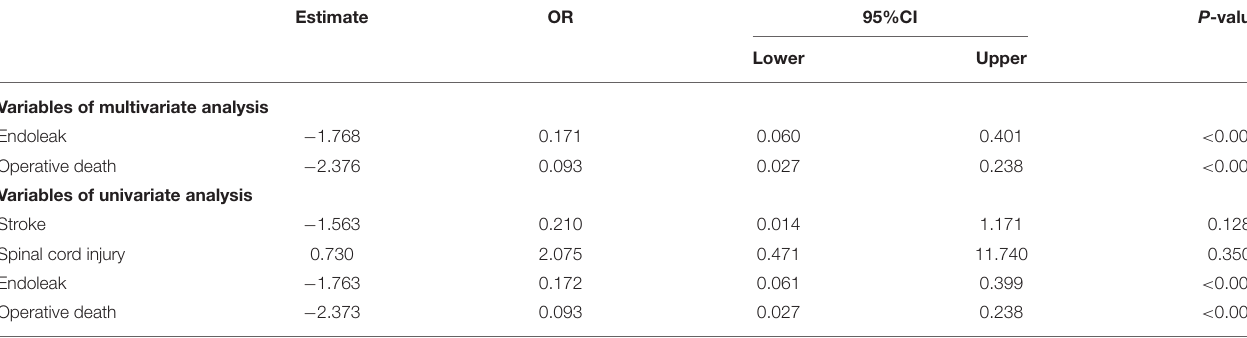
TABLE 3 | AIC stepwise regression analysis of postoperative complications of SET group vs. HAR group (adjusted by